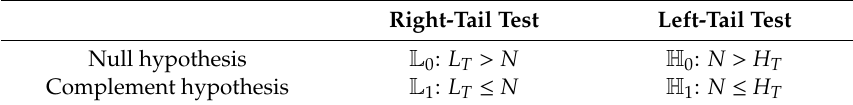
Table A1. Definition of the two single-tailed hypotheses to derive interval limits by left- and right-tailed tests.